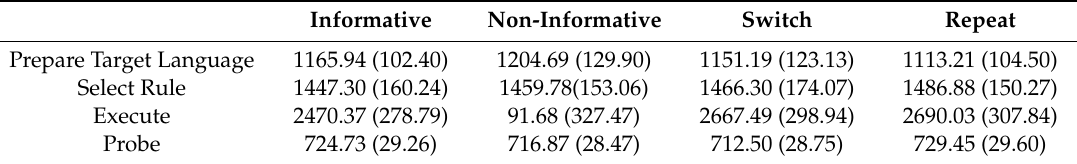
Table 4. Average reaction times (ms) in task phase by informative and non-informative trial.